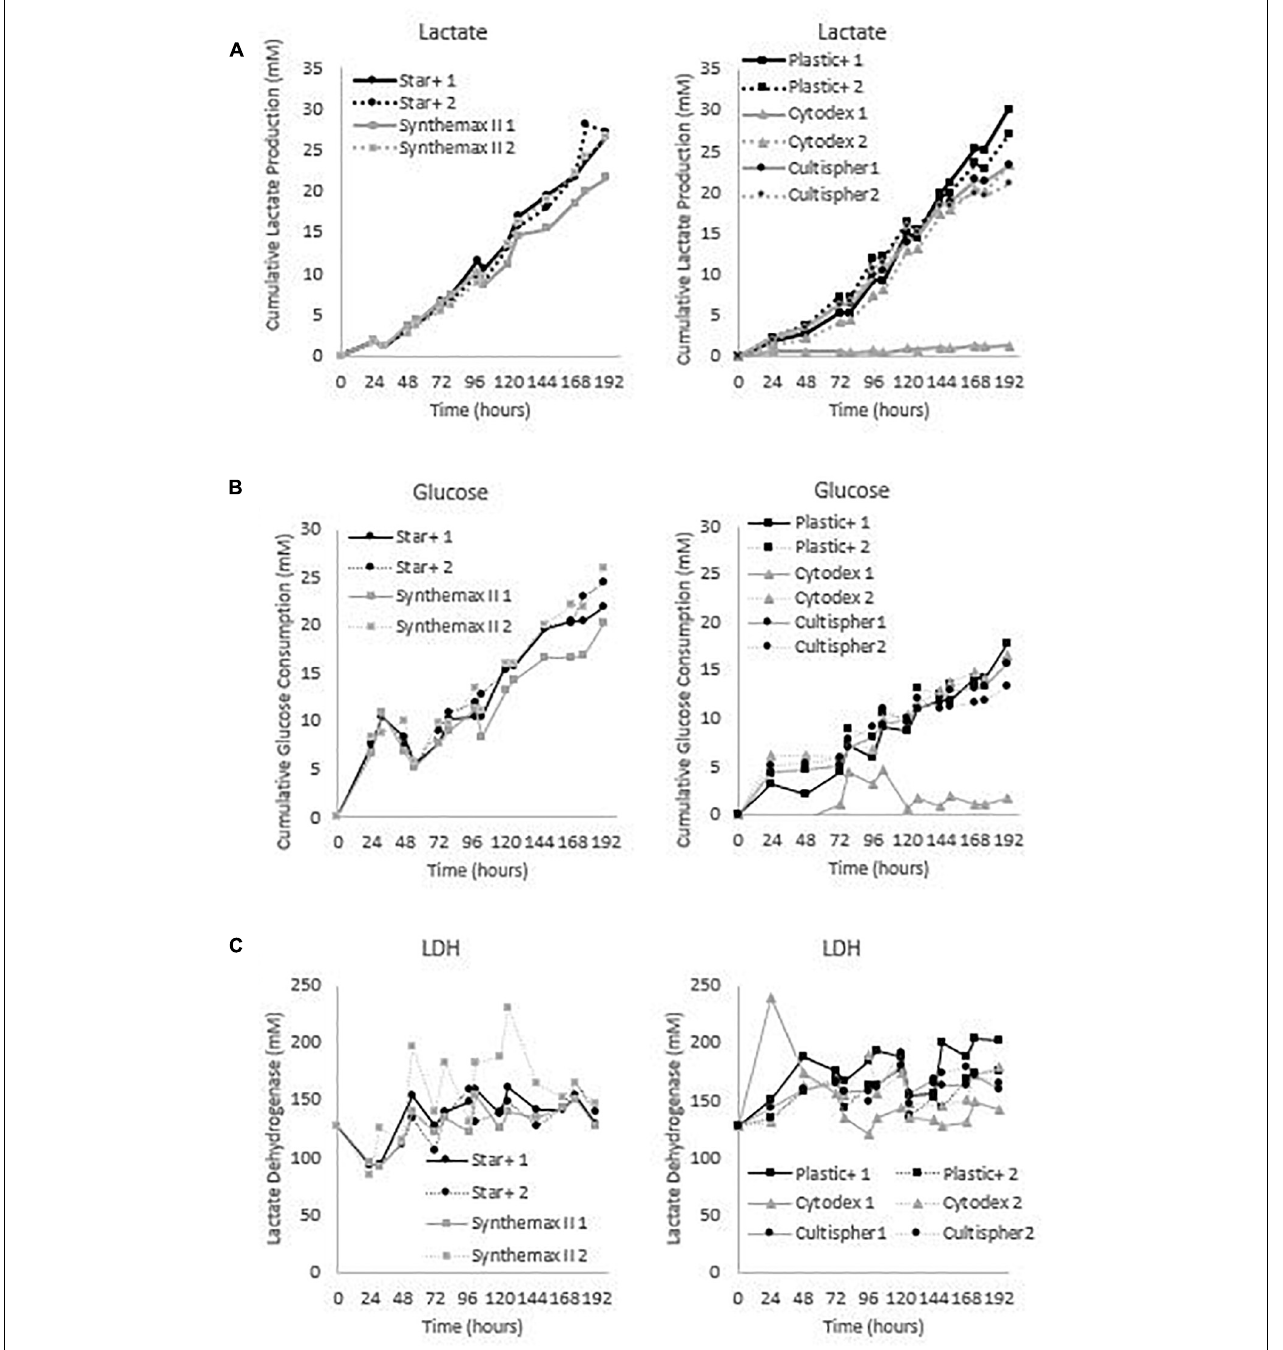
FIGURE 5 | Metabolic profiles for the dynamic screening experiments of the microcarriers Star-Plus, SynthemaxII dissolvable, Plastic-Plus, Cytodex1, and Cultispher-S. The experiments were performed in duplicates for each of the microcarriers. (A) Cumulative lactate measurements, (B) cumulative glucose measurements and (C) Lactate Dehydrogenase (LDH)